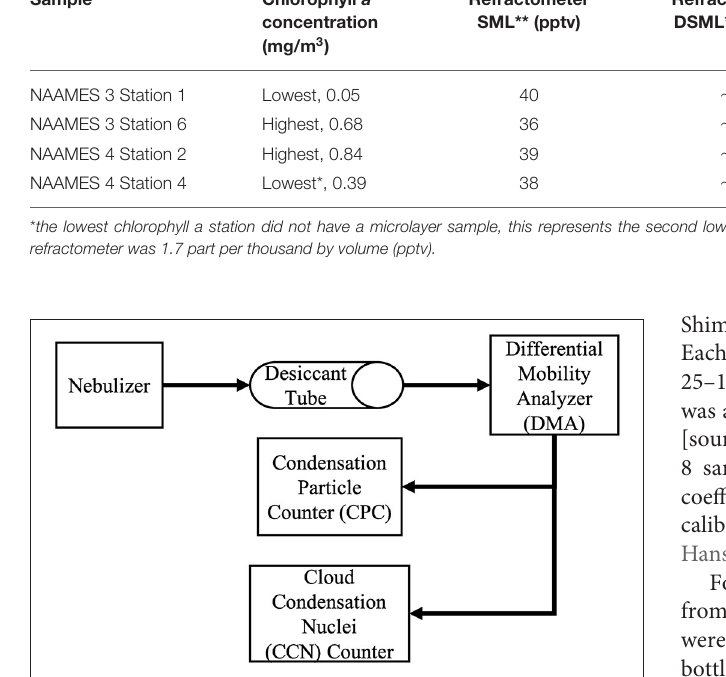
FIGURE 2 | Experimental setup for CCN